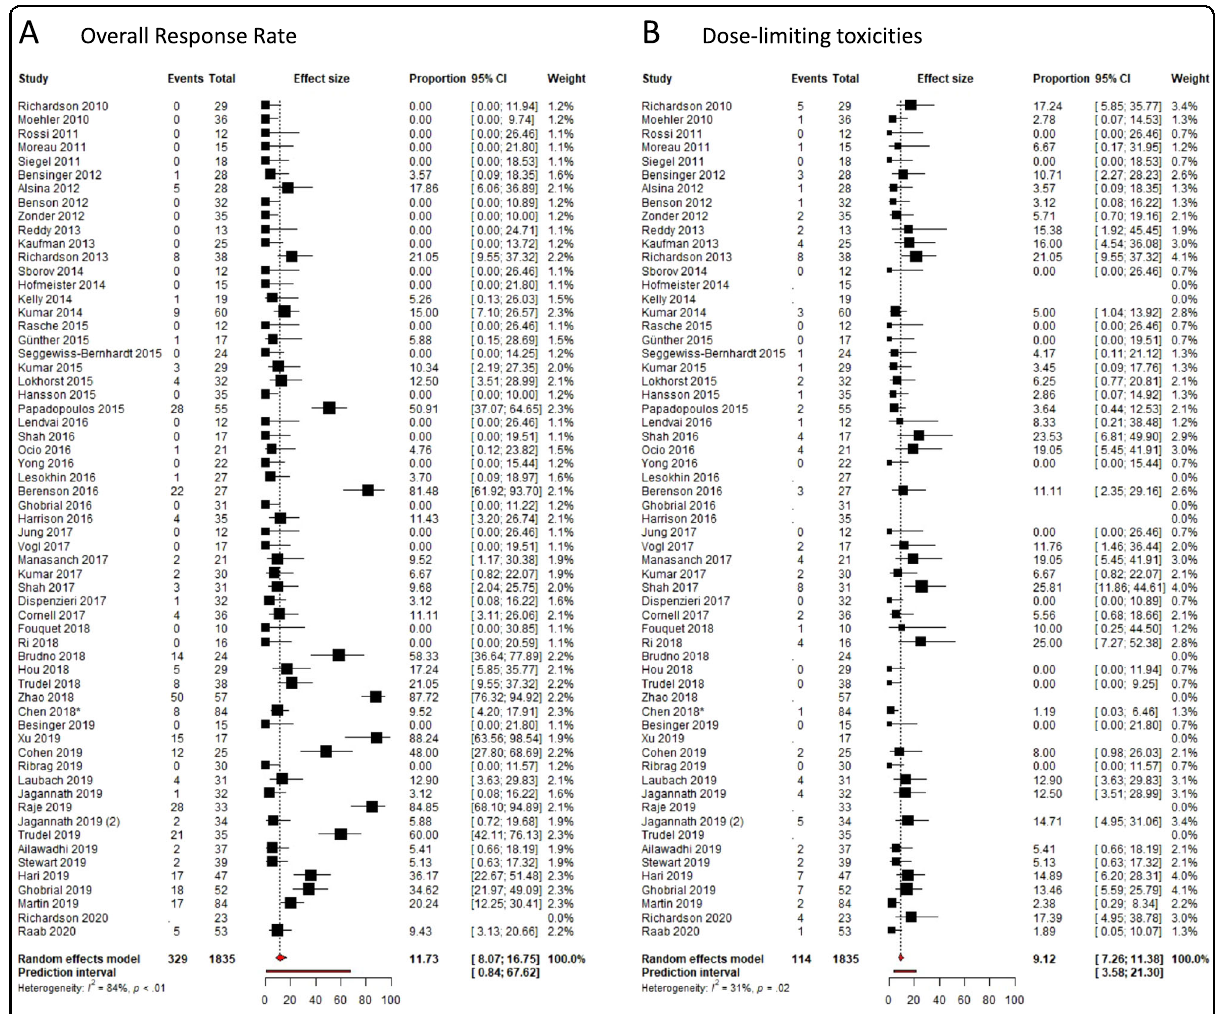
Fig. 2 Forest plots of overall response rates and dose-limiting toxicities in phase I trials. A Overall response rates per included phase I trial. B Drug-limiting toxicities per included phase I trial. Forest plots are arranged by the population size of trials within each year of publication. Squares represent estimated proportions, with the size of the squares representing the weight of each trial according to the inverse variance method. Horizontal lines through the squares indicate 95% CIs. The points of the diamond indicate the 95% CI of the pooled mean. The horizontal line at the bottom indicates the prediction interval. Blank lines indicate missing information from the trial paper. *The study population in Chen et al. 84 included two patients with Waldenström ’ s